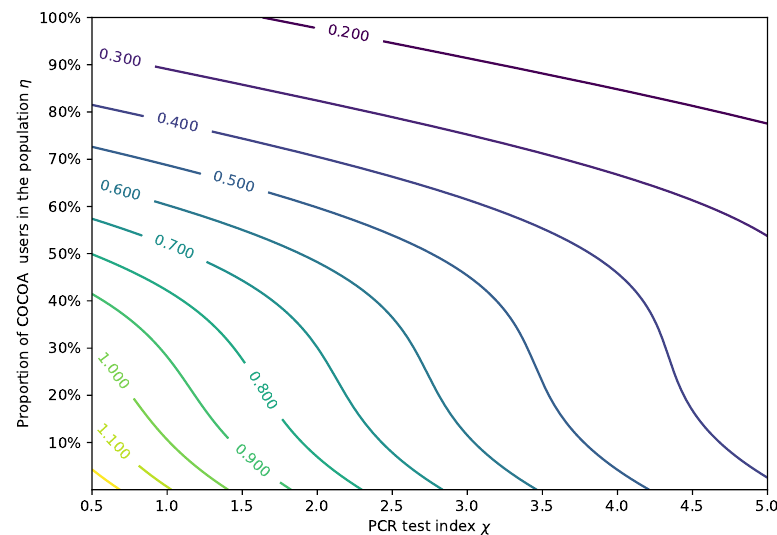
Figure 7. The contour of reproduction number R e with different η and χ